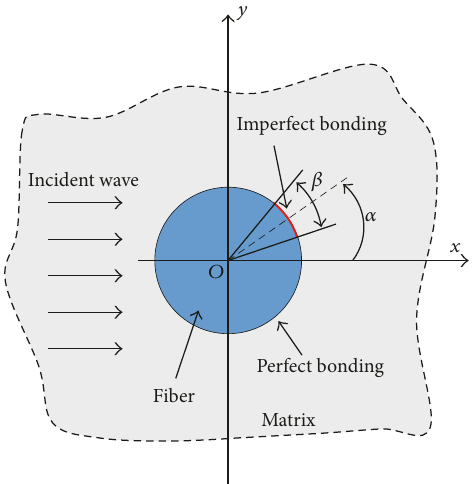
Figure 1: Scattering of a plane SH-wave by a cylindrical fiber with a partial imperfect bonding to the matrix. The range of the imperfect bonding is denoted as the red solid